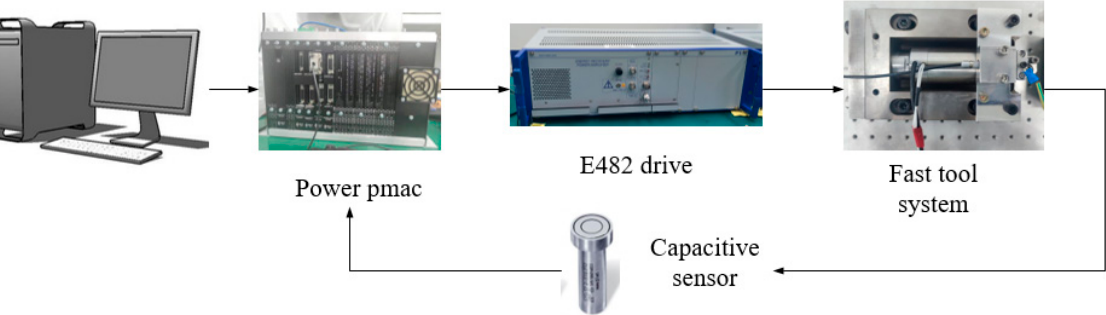
Figure 11. Experimental setup.